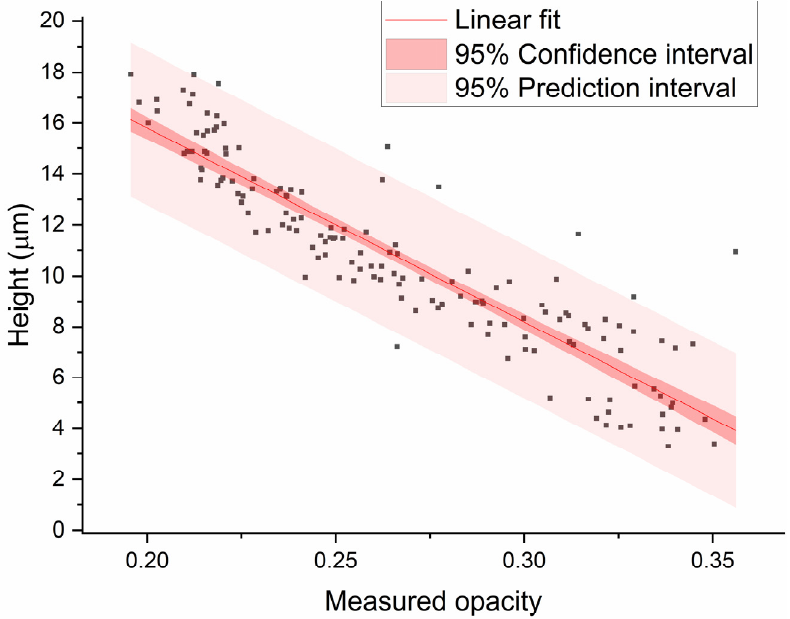
Figure 7. Measured bead height (relative to the electrodes) versus measured opacity ( ∆ | Z | 20MHz / ∆ | Z | 0.5MHz ) for 152 beads. Linear regression analysis was performed to find the 95% confidence and prediction interval. The mean standard deviation (RMSE) of the fit is 1.5 µm (8% of the channel height) and R 2 = 0.83.